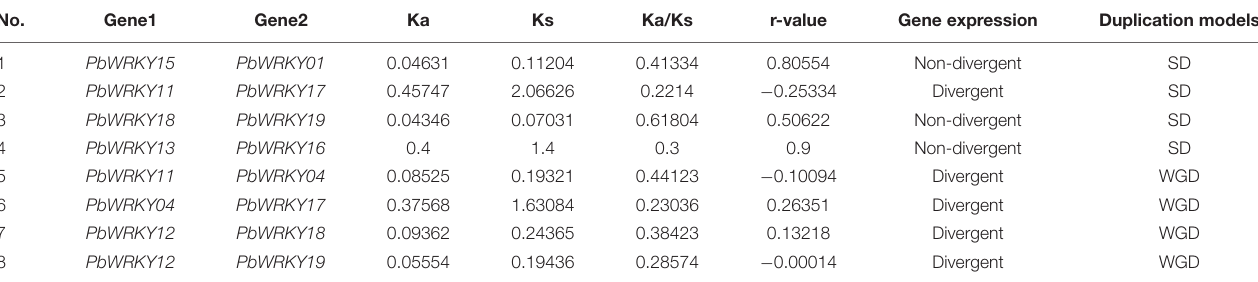
Gene expression Duplication